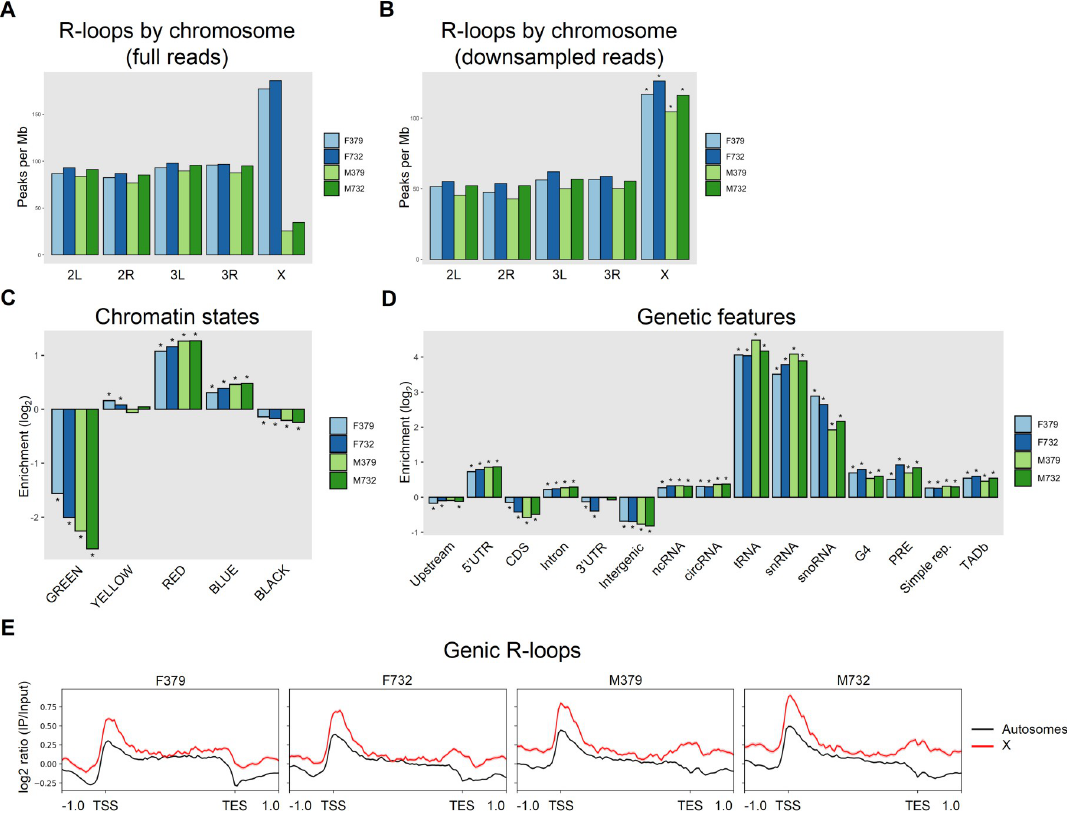
Fig 1. R-loop identification & feature enrichment in D . melanogaster adults. Whole adult flies from strains DGRP379 and DGRP732 were separated by sex and subjected to DRIP-sequencing to detect R-loops. (A) DRIP-seq peak density across chromosomes for the full male and female datasets (i.e. without downsampling) shows an apparent depletion of X-linked R-loops in males. (B) Downsampling all female DRIP-seq reads and autosomal male DRIP-seq reads so that all chromosome arms have similar sequencing depths shows that X-linked R-loops are enriched in both males and females (Binomial test, � = p < 2.2e-16). (C) R-loop formation at chromatin states as described in [34]. (D) R-loop formation at various genetic features. (E) Metaprofiles of R-loop signal across protein-coding genes, autosomes versus X chromosome. For Panels (C) and (D): R-loop enrichment is shown as the observed number of DRIP-seq peaks overlapping each feature (or chromatin state) divided by the expected number of peaks (see Methods). P-values were calculated via a Permutation Test with Benjamini-Hochberg correction for multiple comparisons, � = corrected p < 0.05. For Panel (E): the solid lines represent the mean DRIP-seq signal within each metagene bin, and the shading represents the standard error of the